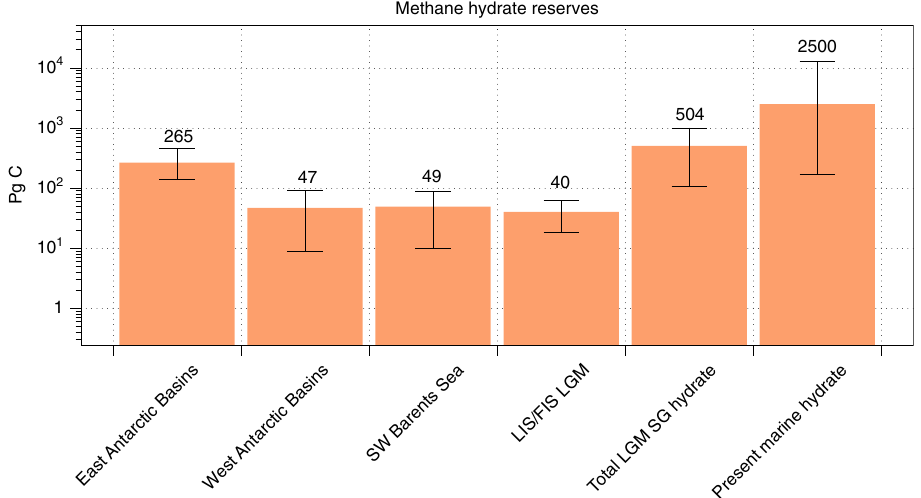
Fig. 4 Potential methane hydrate reserves beneath present and former ice sheets. Data presented includes minimum, mid-range and maximum estimates of carbon reserves. East Antarctic Ice Sheet sedimentary basin methane hydrate + free gas (AIS hydrate, minimum and maximum values taken from ref. 96 , with mid-range values as the average between the two), West Antarctic Ice Sheet sedimentary basin methane hydrate + free gas (WAIS hydrate, minimum and maximum estimates taken from ref. 96 , with mid-range values as the average between the two), the SW Barents Sea LGM hydrate 165 (mid- range values are the average of the minimum and maximum published values from ref. 165 ), Laurentide and Fennoscandian Ice Sheet estimates of potential methane hydrate (minimum and mid-range estimates from estimates of methane hydrate carbon modelled in ref. 17 . and maximum estimates taken